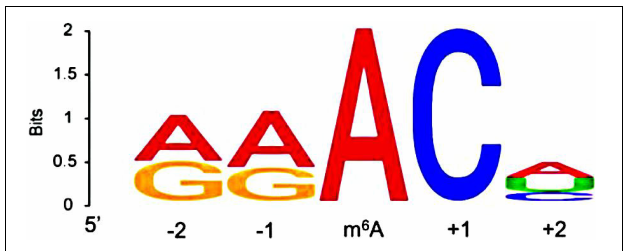
FIGURE 1 | The canonical RRACH motif. R, adenine or guanine; H, cytosine, adenine, or uracil.